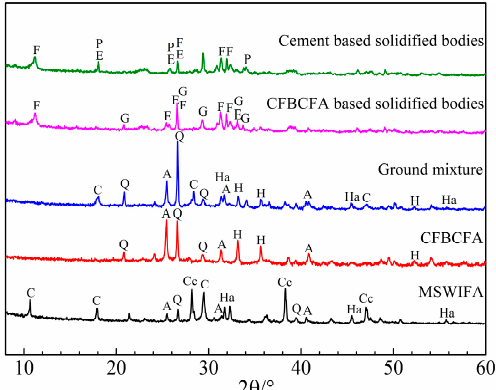
Figure 5. XRD patterns for the raw materials, ground mixture, and solidified bodies (A-Anhydrite; C-Calcite; E-Ettringite; F-Friedel’s salt; G-Gismondine; H-Hematite; Ha-Halite; P-Portlandite; Q-Quartz; Cc-Calcium hydroxyl chloride).